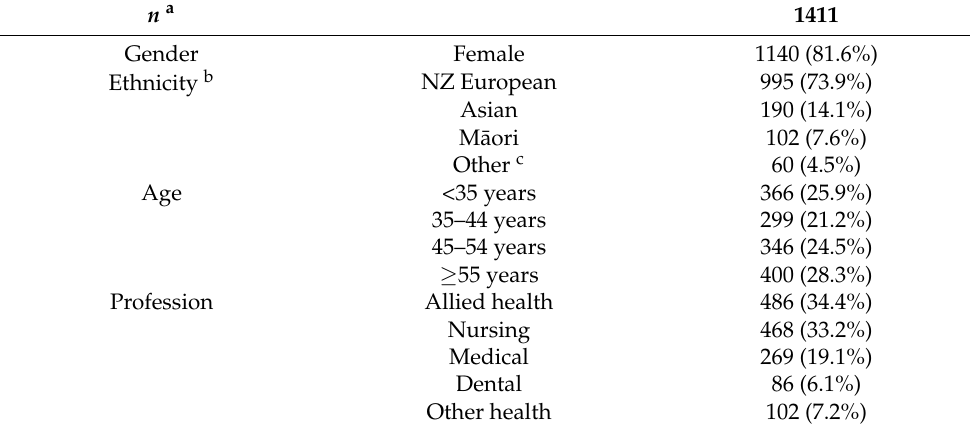
Table 1. Demographic characteristics of survey